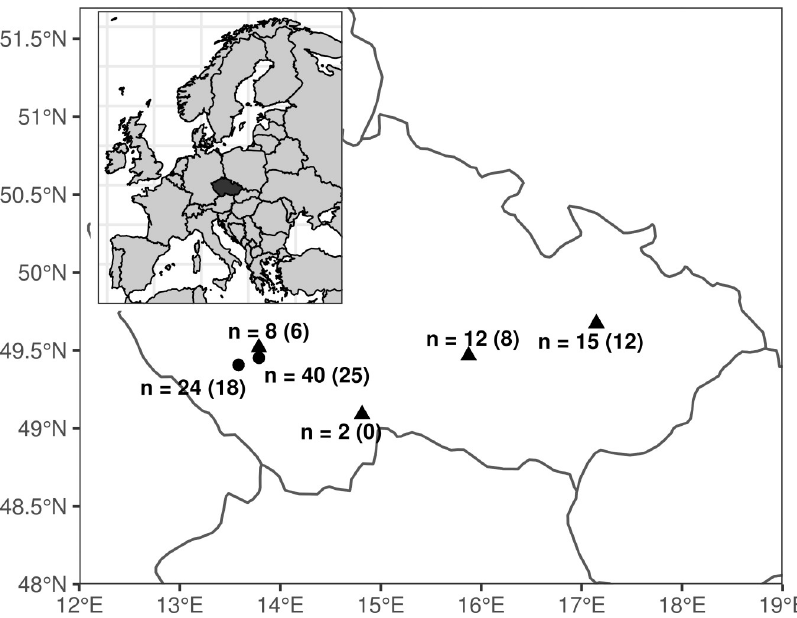
Fig 1. The geographical distribution of the localities (Czech Republic) where mallard eggs were sampled is indicated by triangles (free-living populations) or circles (duck game-farms). Sample sizes (n) for each location is shown together with numbers of hatched individuals, in